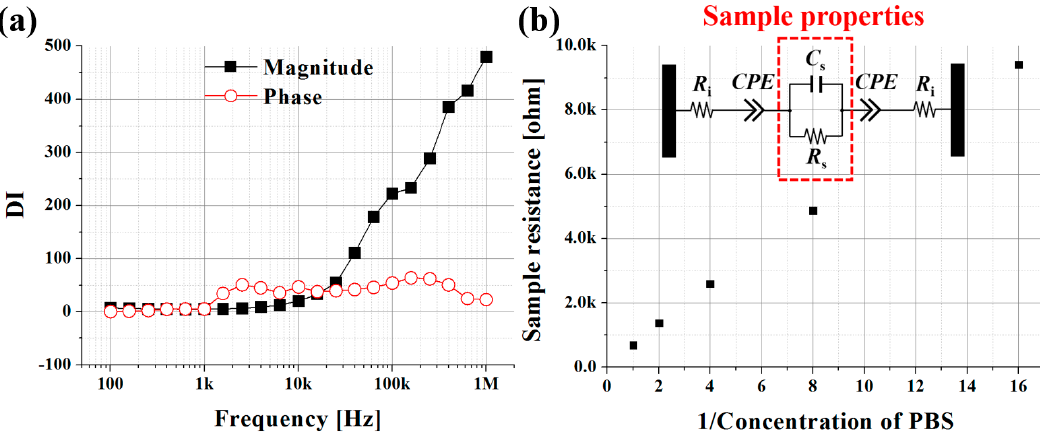
Figure 4. ( a ) Discrimination index ( DI ) to find the optimal frequency at which the discrimination capability of µ EoN-DP was maximized; and ( b ) the linearity of extracted sample resistance, along with the reciprocal value of PBS concentration. The inset represents the electrical equivalent circuit to extract the resistance ( R s ), capacitance ( C s ), and CPE parameters (Y 0 and n) .